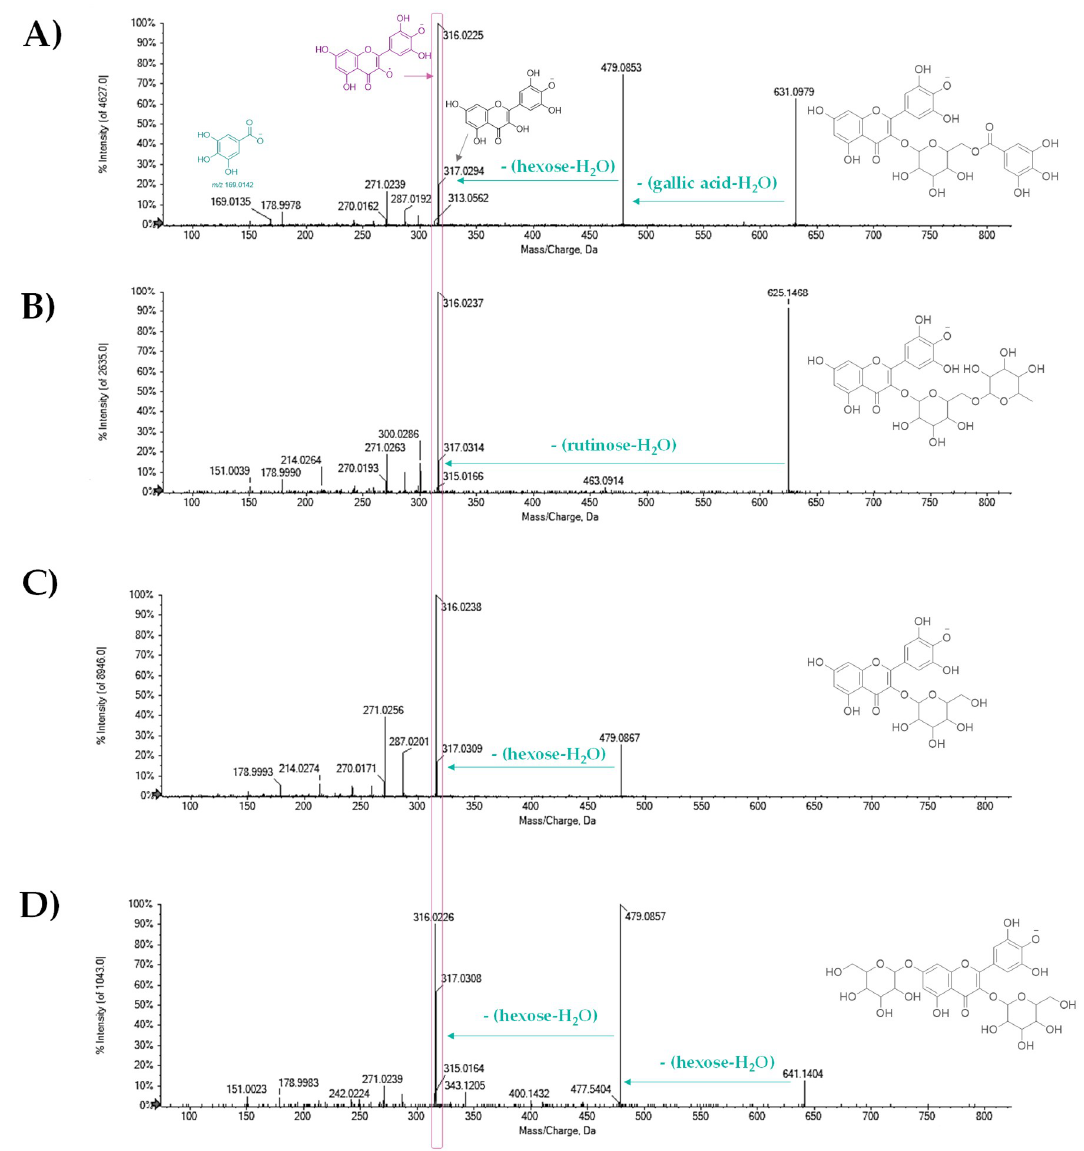
Figure 3. TOF-MS / MS spectra of [M − H] − ion of myricetin glycosides ( A ) 18 , ( B ) 20 , ( C ) 21 , and ( D ) 22 . The structure of the deprotonated molecular ion is reported on the left, whereas the main neutral losses are evidenced by green arrays.